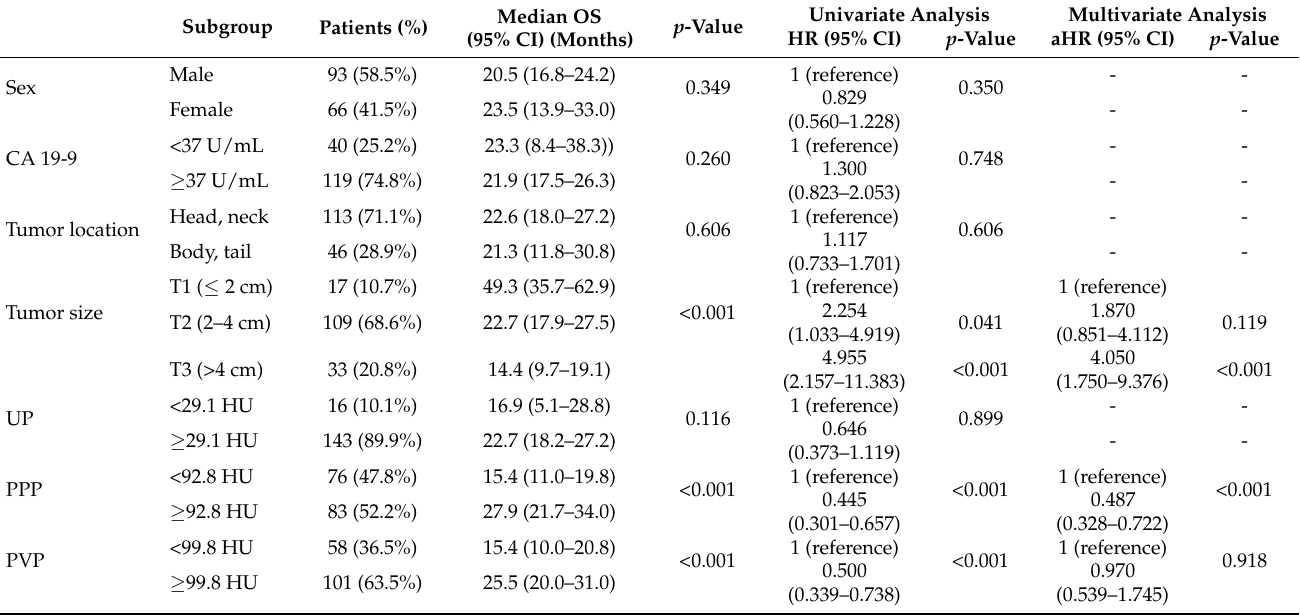
Table 3. Univariate and multivariate Cox hazard regression analysis of clinical and radiologic parameters in patients with resectable pancreatic cancer on initial CT scan ( n = 159).